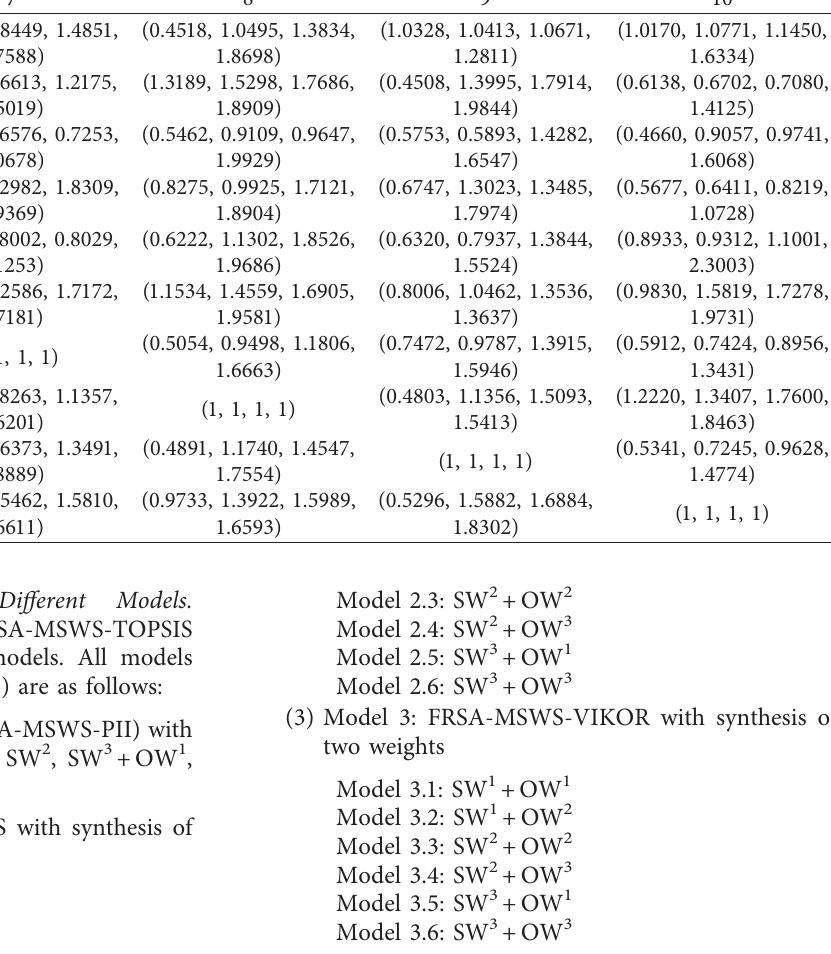
Table 4: LRL matrix 􏽥 Λ 1